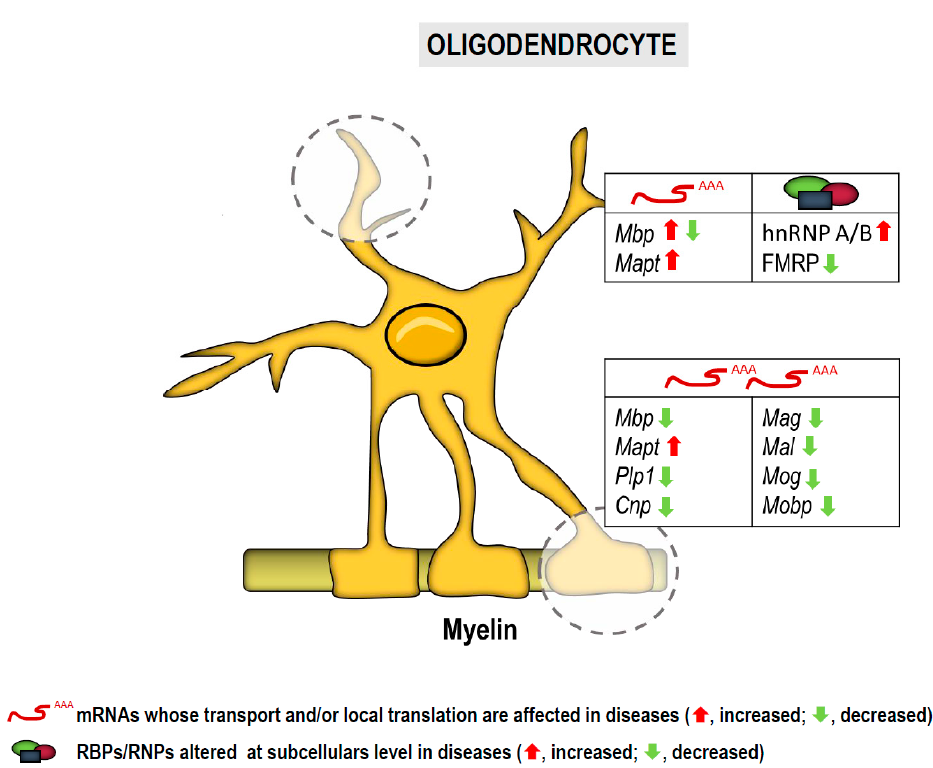
Figure 3. Transcripts and RBPs localized to subcellular compartments in oligodendroglia potentially involved in neurological and neurodegenerative diseases. Local translation occurs both in processes (upper table) and in the myelin sheath (lower table). Arrows indicate altered levels (red, increase; green, decrease) of mRNAs and/or proteins in diseases.